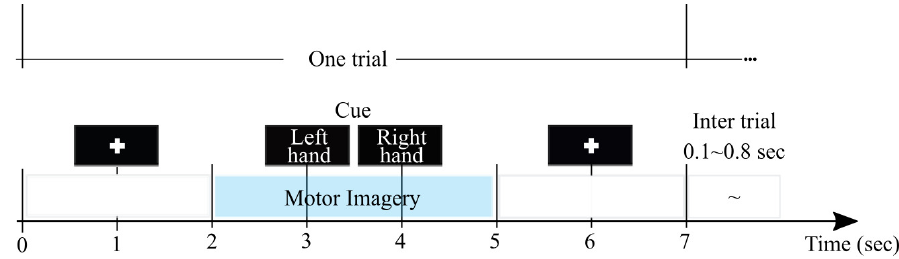
Figure 2. Block diagram and trial timing used to complete the MI database